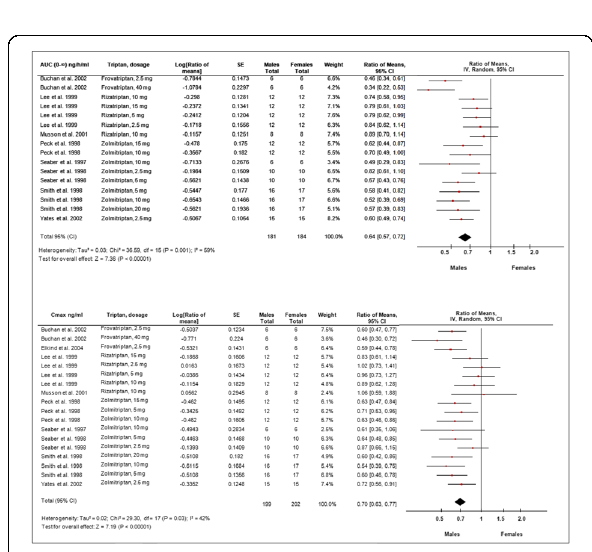
Fig. 3 (abstract P85). Forest plots of AUC0- ∞ and Cmax after the intake of frovatriptan, rizatriptan or zolmitriptan in male and female migraine patients.